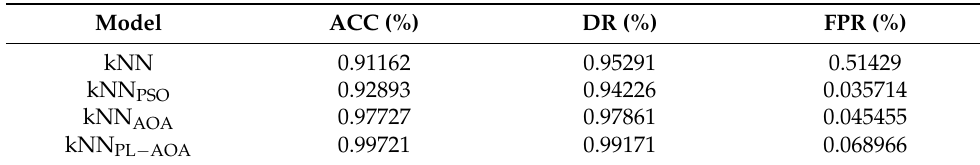
Table 4. Classification effects of the four